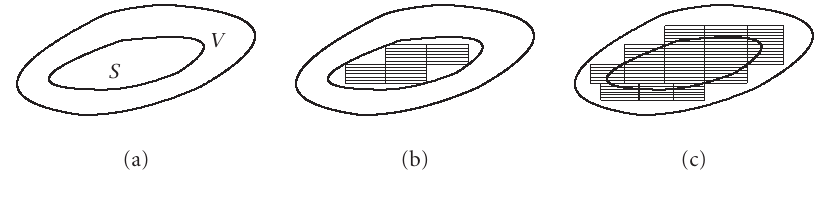
Figure 2.1 (a) S ⊂ V . (b) E − ( S ) ⊆ S . (c) S ⊆ E + ( S